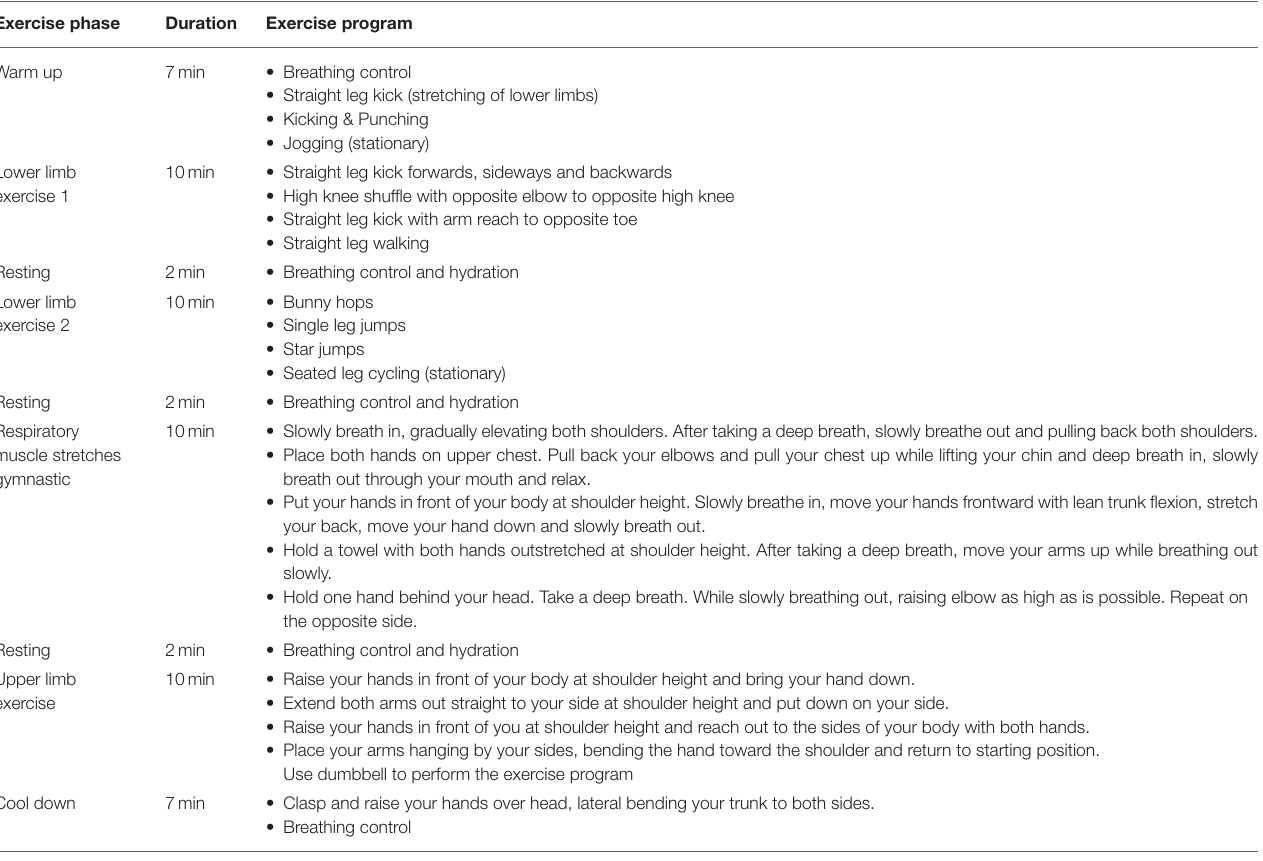
TABLE 1 | Land-based and water-based exercise program (8). Exercise phase